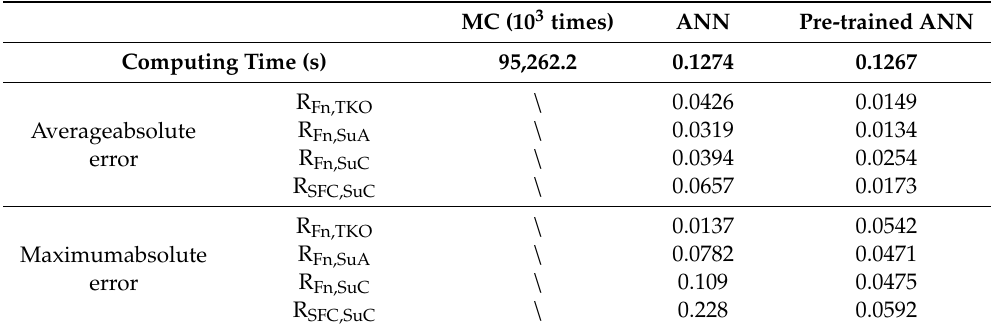
Table 6. Comparison of computing time and precision (20 testing samples). MC = Monte Carlo.